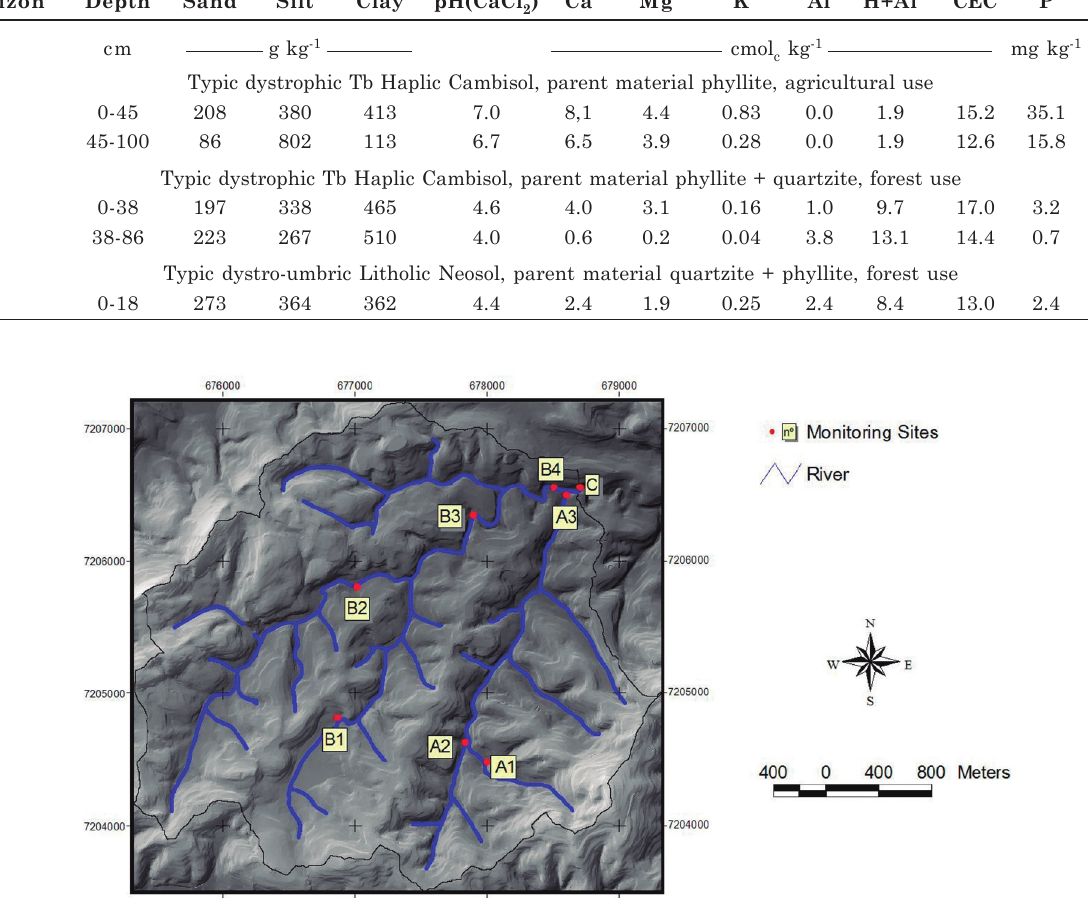
Figure 2. Digital elevation model and monitoring sites in the Campestre catchment.